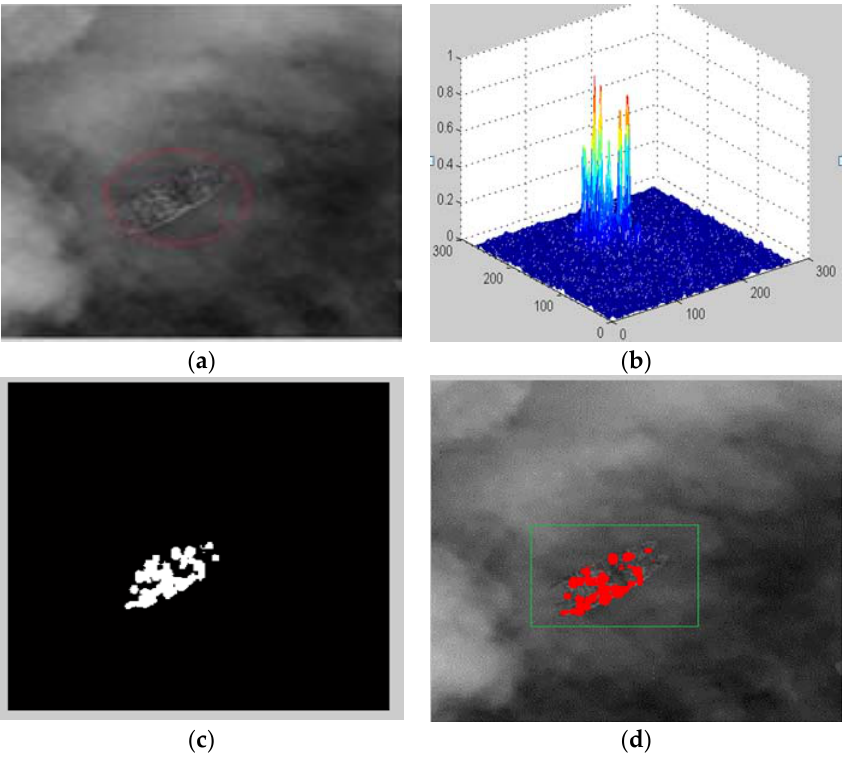
Figure 5. The result of localization of ROI based on PSMEWT. ( a ) The original image; ( b ) the phase significant map; ( c ) the binary image after adaptive dynamic threshold method; and ( d ) the localization of the ROI.